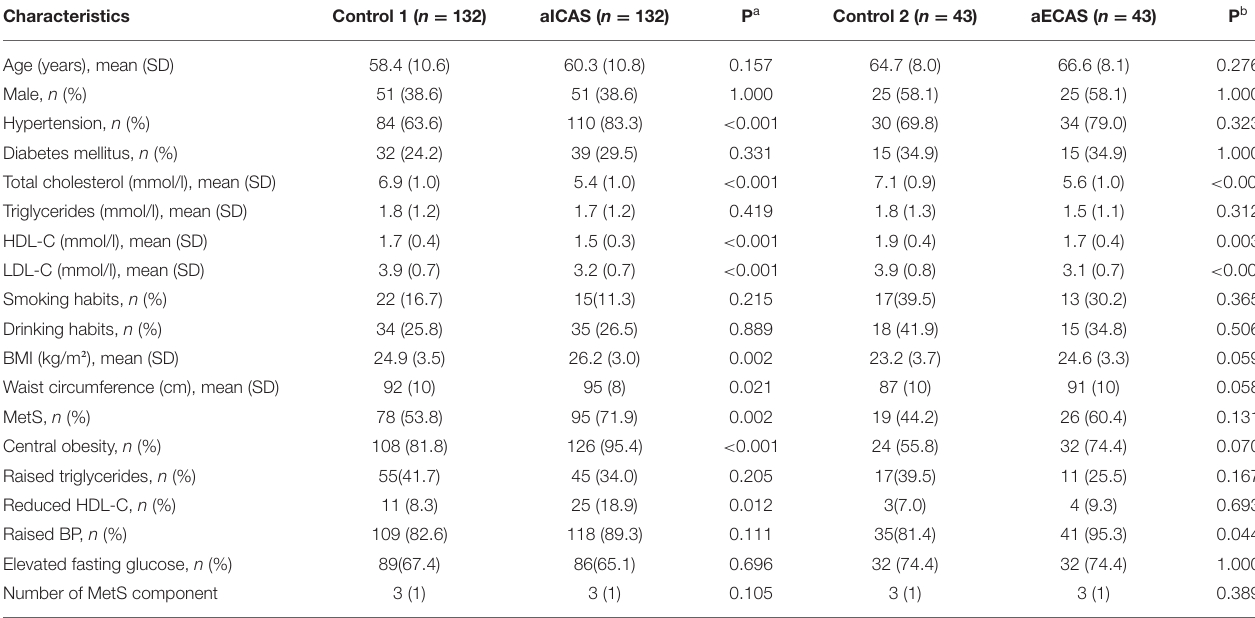
TABLE 2 | Demographic and clinical characteristics of the participants after matching for age and sex.